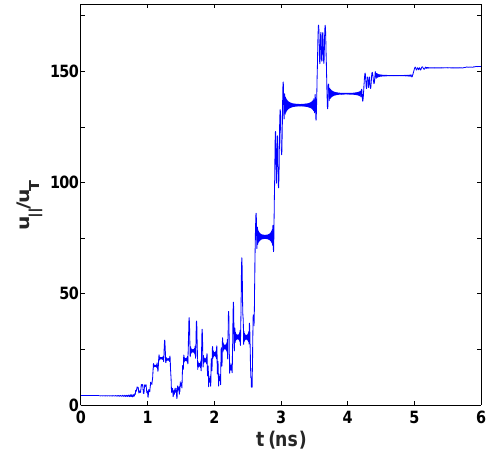
Figure 7. Same as Fig. 5 except that the beam power is 10 MW